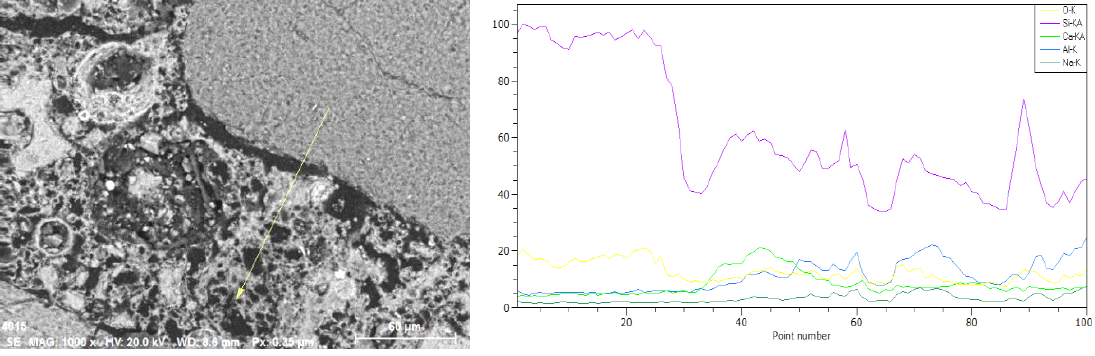
Figure 12. Linear analysis carried out with a scanning microscope using an EDS detector, under variable vacuum conditions, 1000× magnification, EHT 20kV, WD 8.6 mm, mortar with GGBFS annealed at 1000 °C, designated as M50/1000 °C.